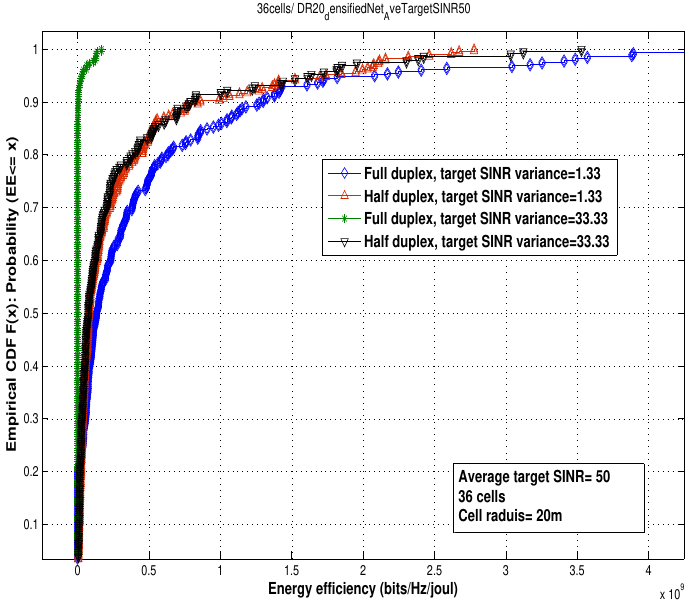
Figure 7. The CDF of the energy efficiency (EE) under different target SINR variance.